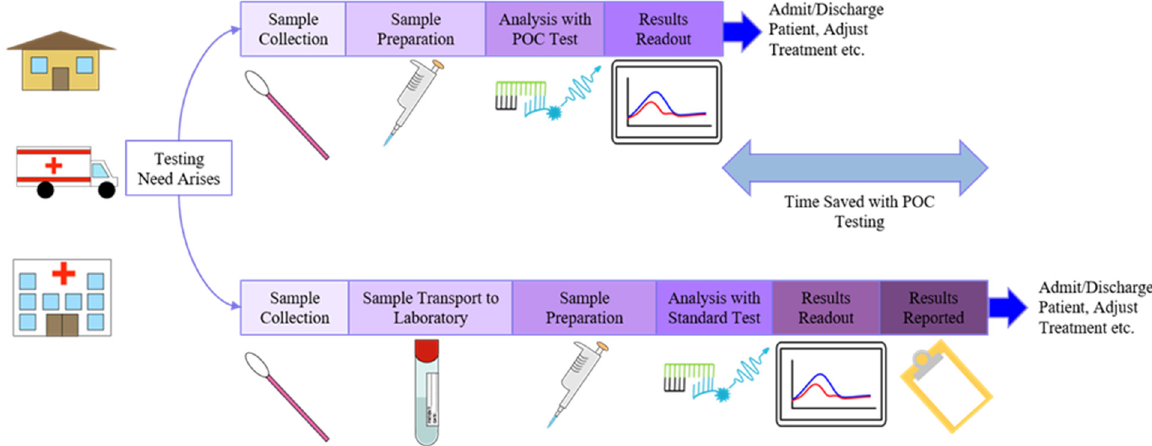
Figure 2. Comparison of the workflows for diagnostic methods in point-of-care (POC) settings ( top ) and standard centralized laboratory settings ( bottom ).